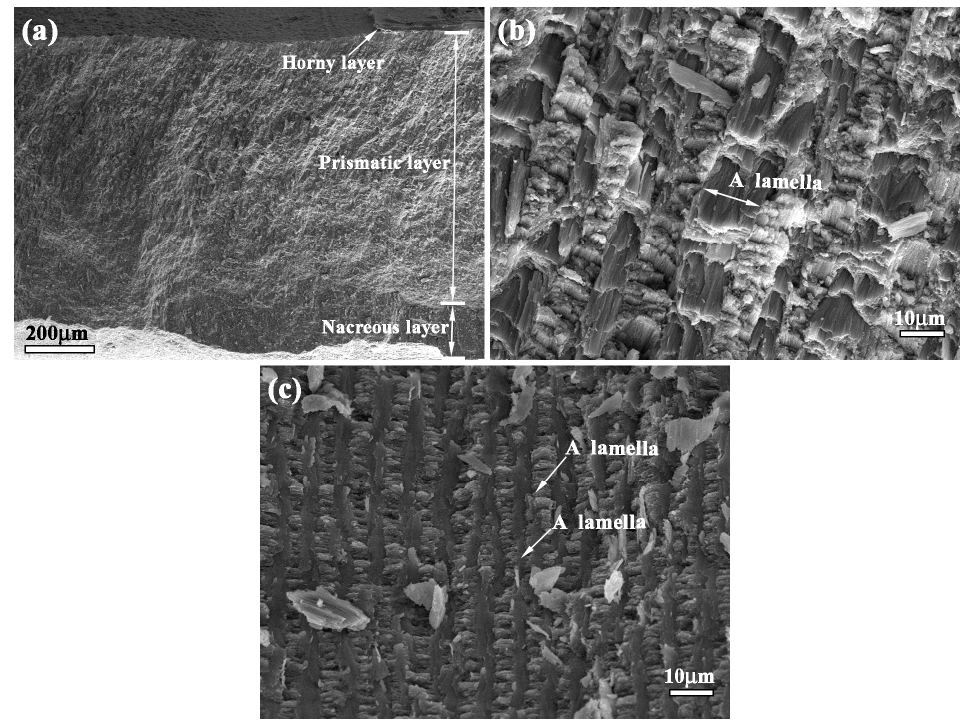
Figure 1. Microstructure of white clam shell ( a ) horny layer ( b ) prismatic layer and ( c ) nacreous layer.